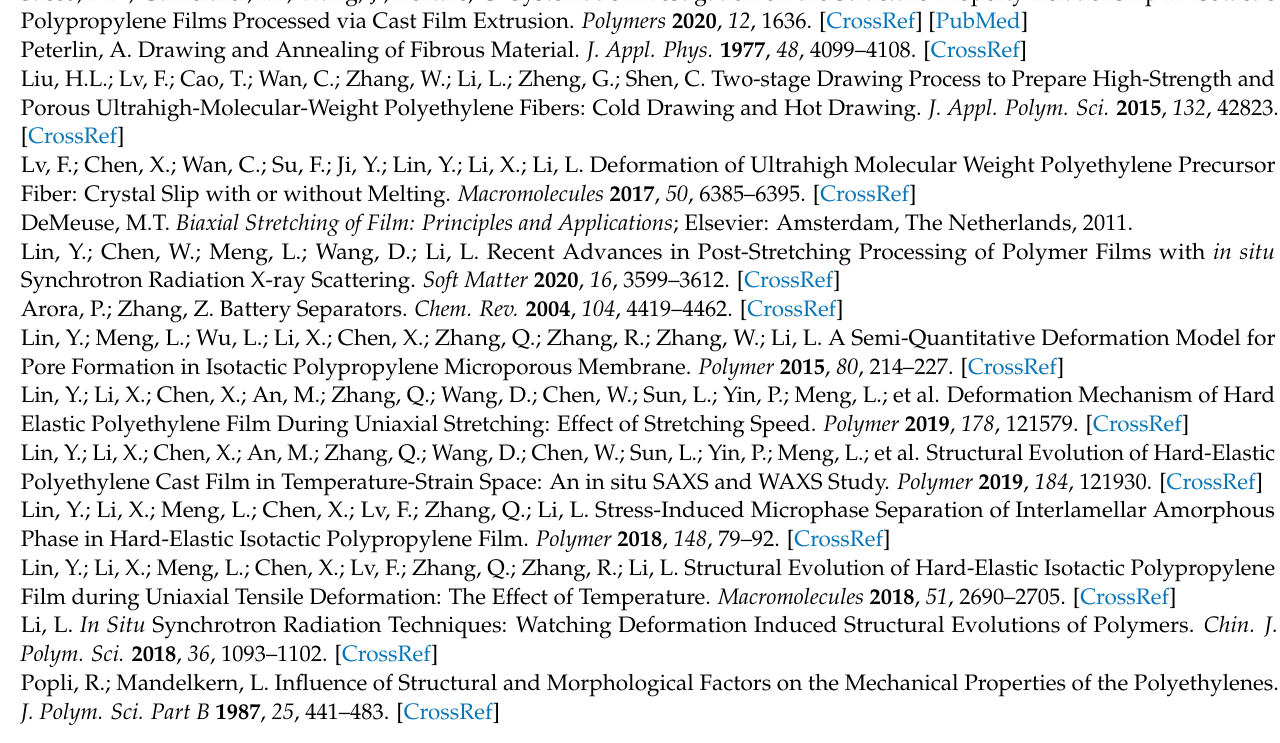
C are indicated, Figure S6: The experimental device setup for the WAXS measurement carried out at the beamline BL19U2 in the Shanghai Synchrotron Radiation Facility